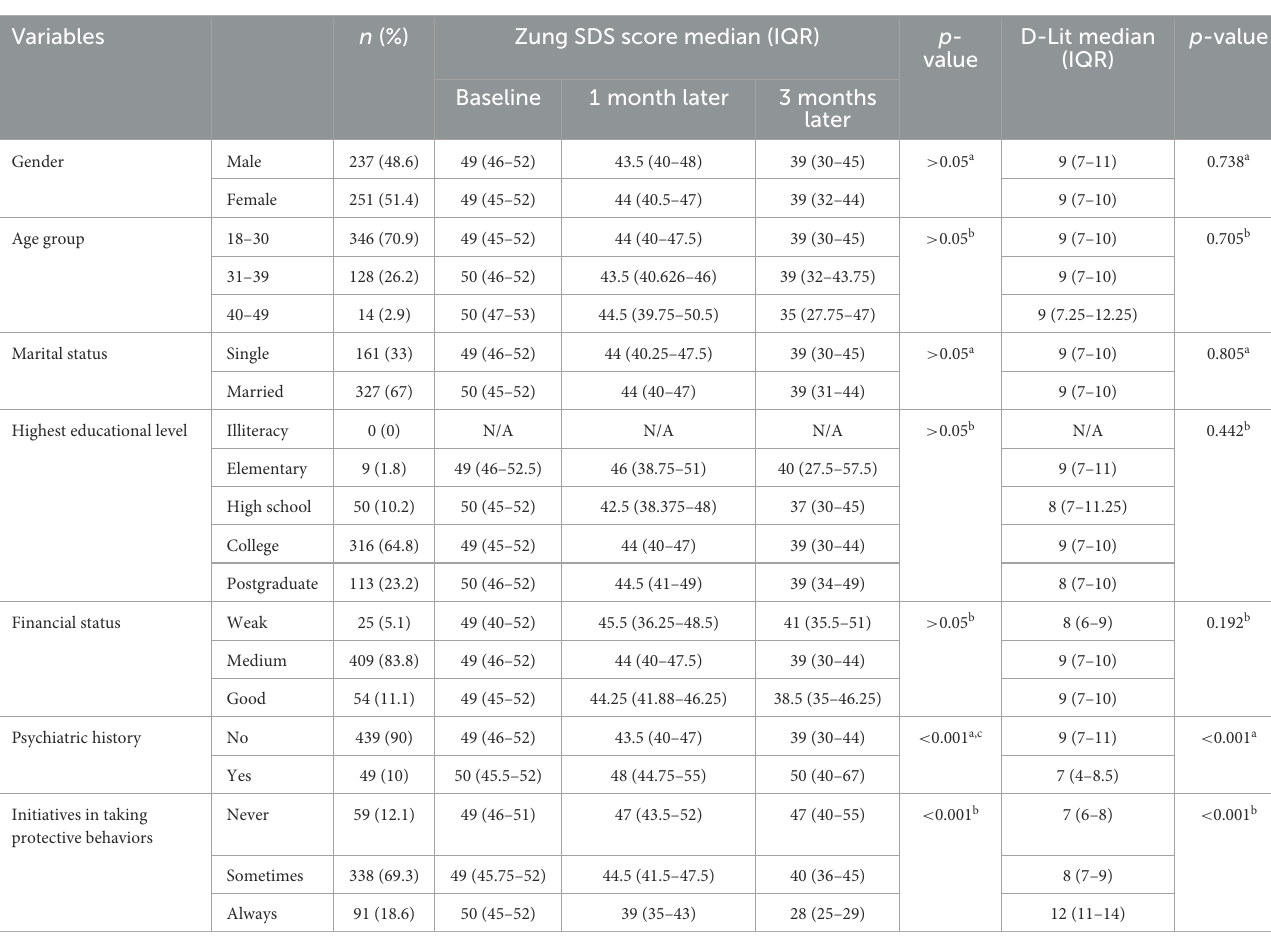
TABLE 2 Non-parametric assessments of demographic factors ( n = 488).